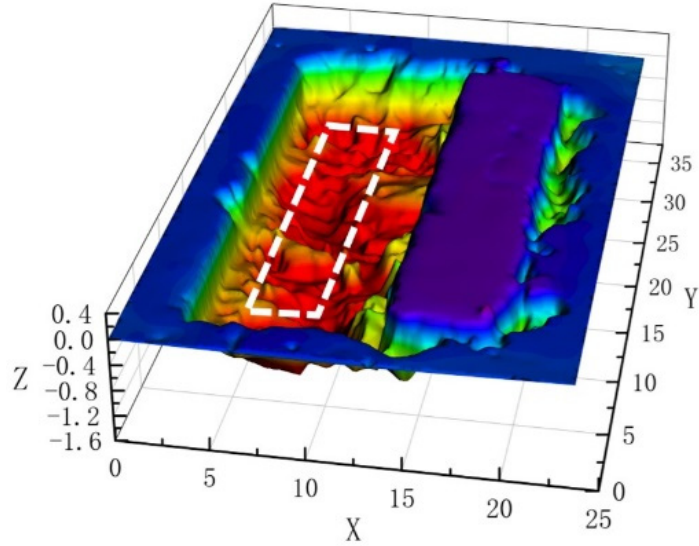
Figure 14. Point cloud data area selection.